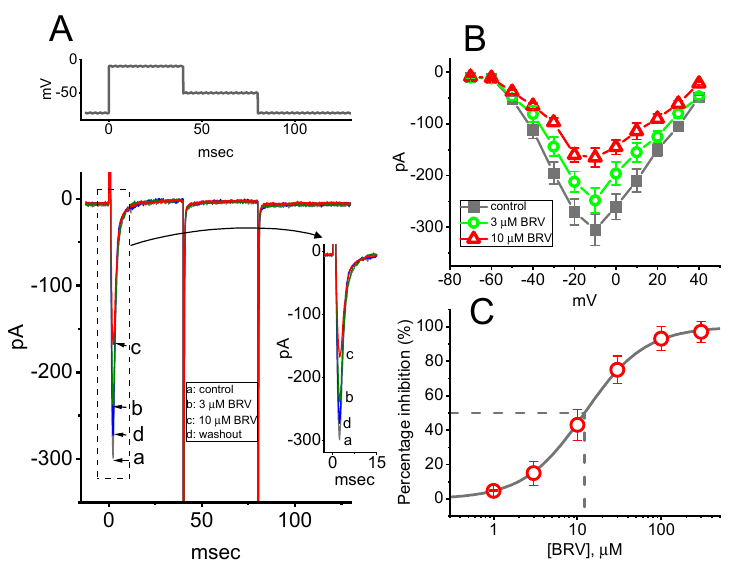
Figure 4. Inhibitory effects of BRV on voltage-gated Na + current ( I Na ) in GH 3 cells. The cells were bathed in Ca 2+ -free Tyrode’s solution containing 10 mM tetraethylammonium chloride, where the recording electrode was filled with a Cs + -containing solution. ( A ) Representative I Na traces activated by rapid membrane depolarization (indicated in the upper part of the figure). Inset shows an expanded record from the dashed box. (a): control (i.e., BRV not present), (b): 3 µM BRV, (c): 10 µM BRV and (d): washout of BRV. ( B ) Mean I-V relationships of peak I Na obtained in the absence ( ● ) and in the presence of 3 µM BRV ( ○ ) and 10 µM BRV ( △ ) (mean ± SEM; n = 7–8). The current amplitude was measured at the beginning of each brief depolarization. It should be noted that cell exposure to BRV depressed the amplitude of the peak I Na ; however, the overall I-V relationship with the current was not altered. Furthermore, the activation and inactivation time courses of the peak I Na were clearly modified in the presence of BRV. ( C ) Concentration-dependent inhibition of peak I Na caused by different BRV concentrations (mean ± SEM; n = 7). Peak I Na was activated by rapid depolarization from − 80 to − 10 mV. The vertical broken line was placed on the IC 50 value of BRV used to show the inhibition of peak I Na amplitude in response to the depolarizing command voltage.